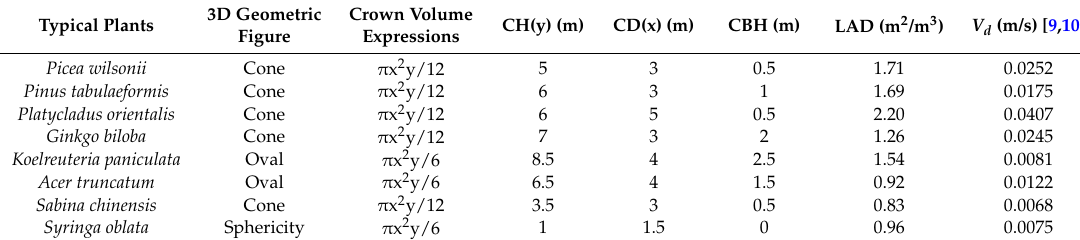
Table 1. Vegetation parameter setting in numerical simulations.